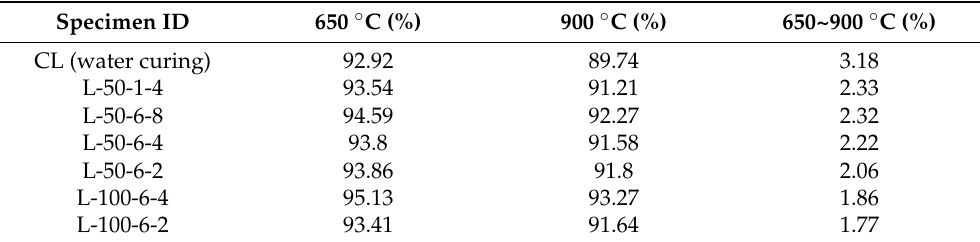
Figure 10. TGA curves for water and CO 2 cured concrete samples. Table 8. Mass loss (%) for water and CO 2 cured concrete over different temperature ranges.